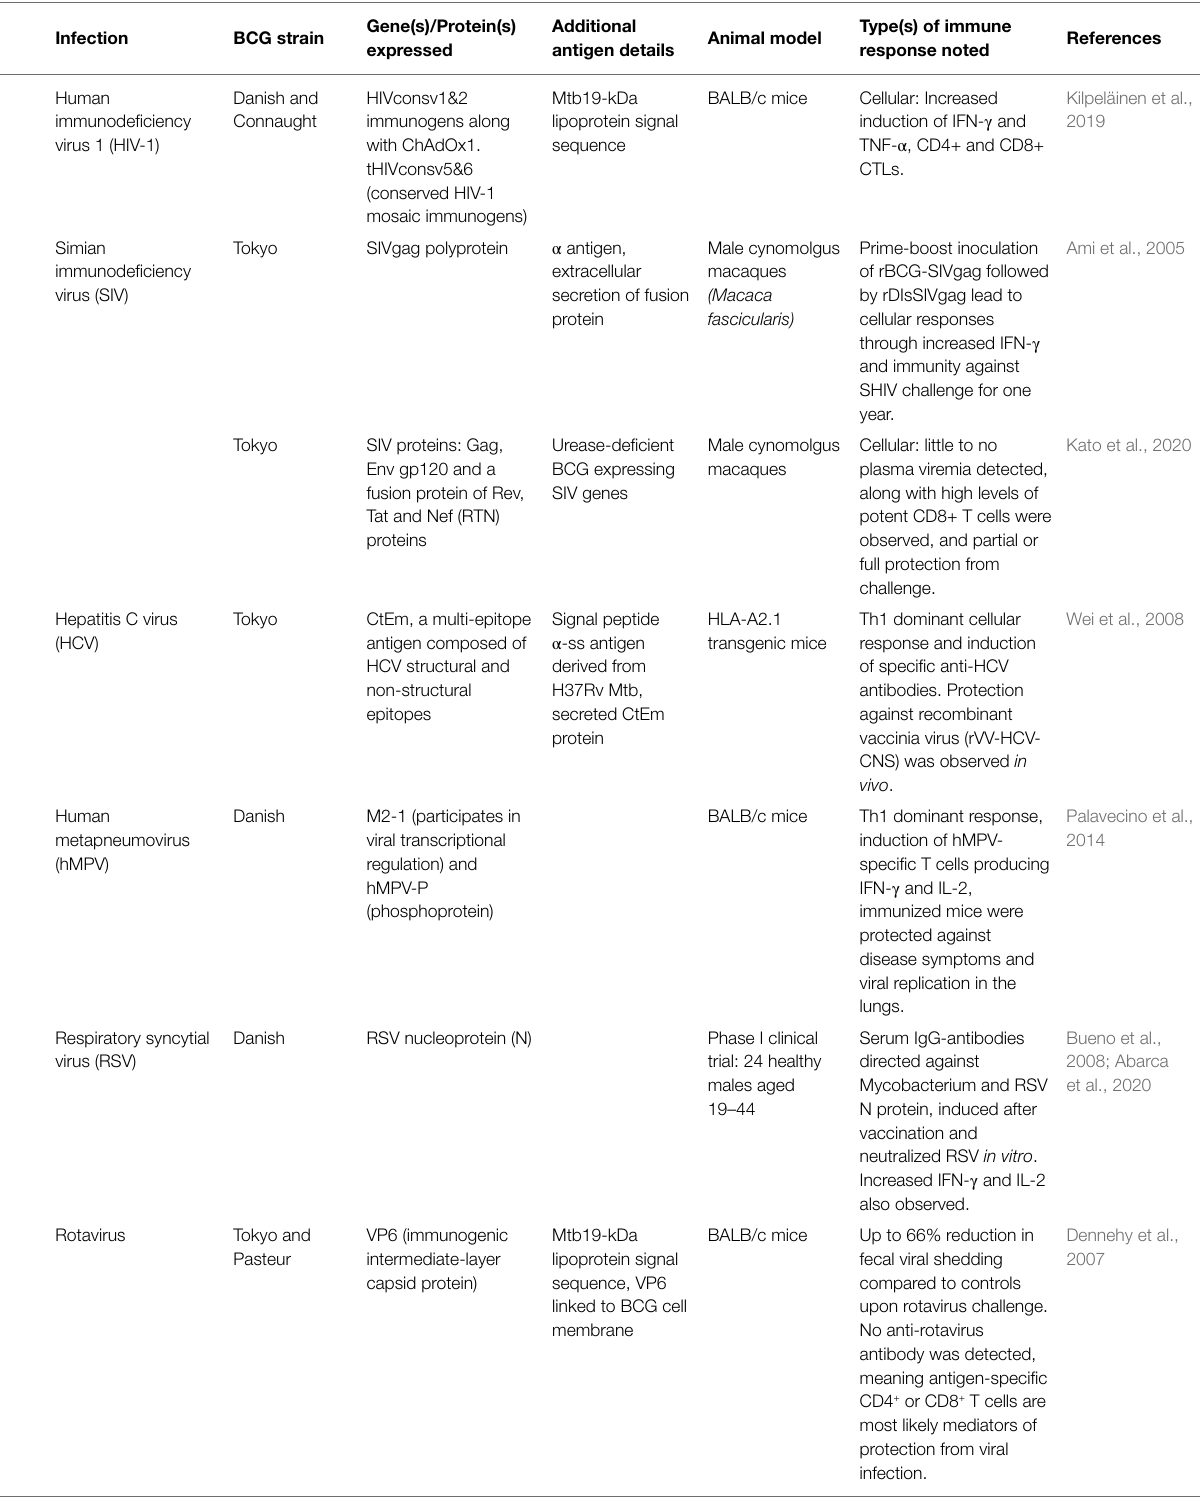
TABLE 1 | rBCG vaccine candidates and their immune responses against various viral, parasitic, or bacterial challenges.